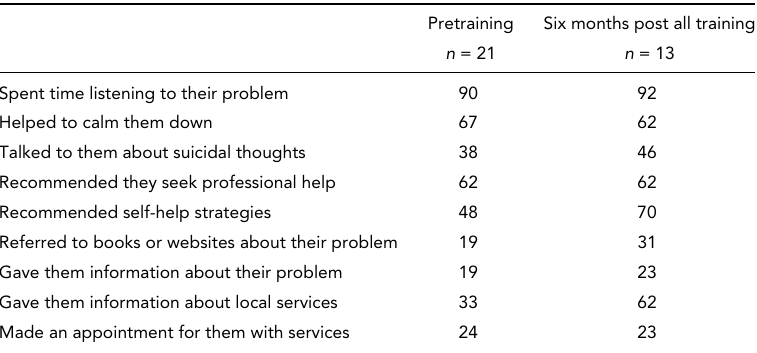
Percentage of Participants Reporting use of Actions when Talking to Students About Mental Health Concerns in Six Months Prior to